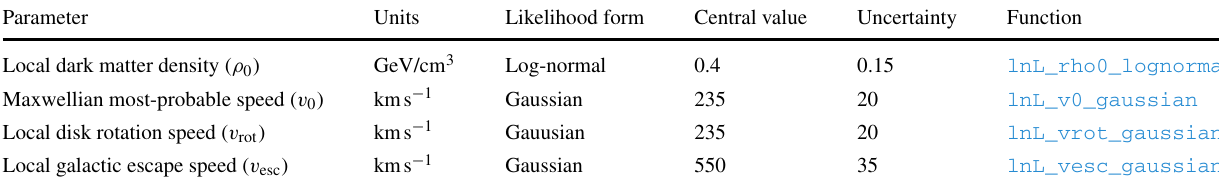
Table 1 Milky Way halo parameters used in DarkBit , the form of their likelihood functions, their central values and 1 σ uncertainties, and the function that provides each likelihood. The capabilities associated with